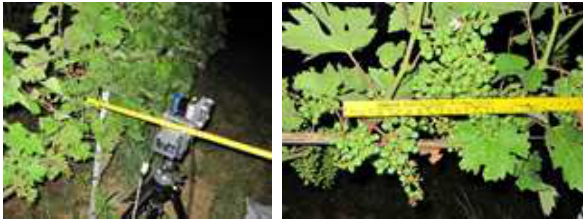
Figure 1: Photos showing the early stage of grape